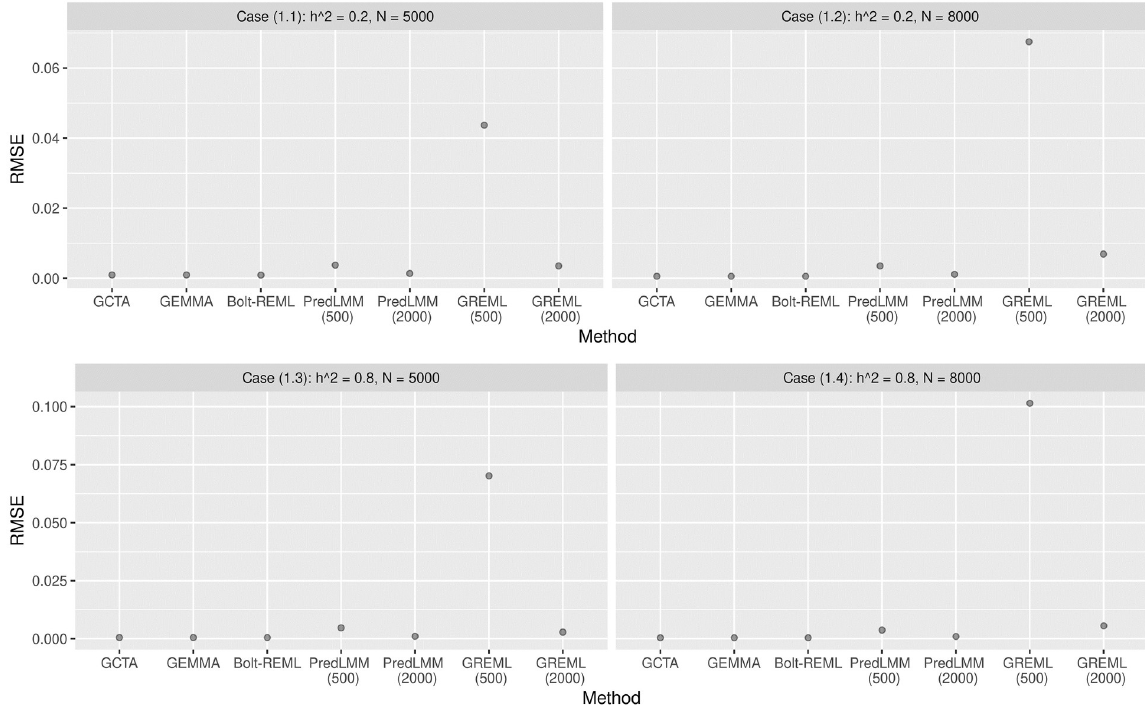
Fig 2. The figure shows the empirical RMSE of different methods from Simulation Study 1. Each of the four sub-plots corresponds to four different cases. For every case, 100 replications were considered. GREML (sub) had very high RMSE compared to PredLMM and the latter had RMSE close to the full GREML based